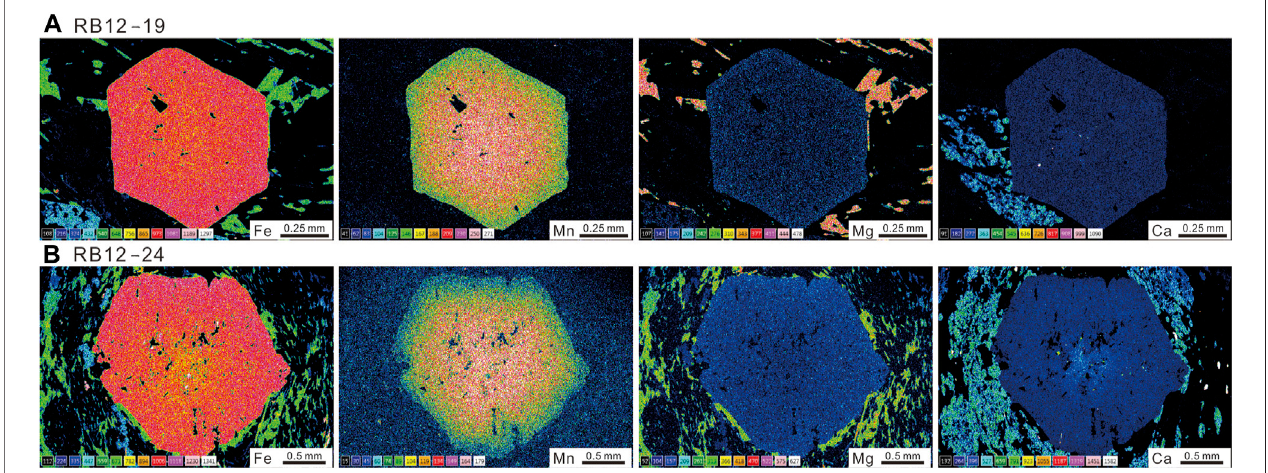
FIGURE 5 | Compositional mapping images of garnets in schist samples RB12-19 (A) and RB12-24 (B) .